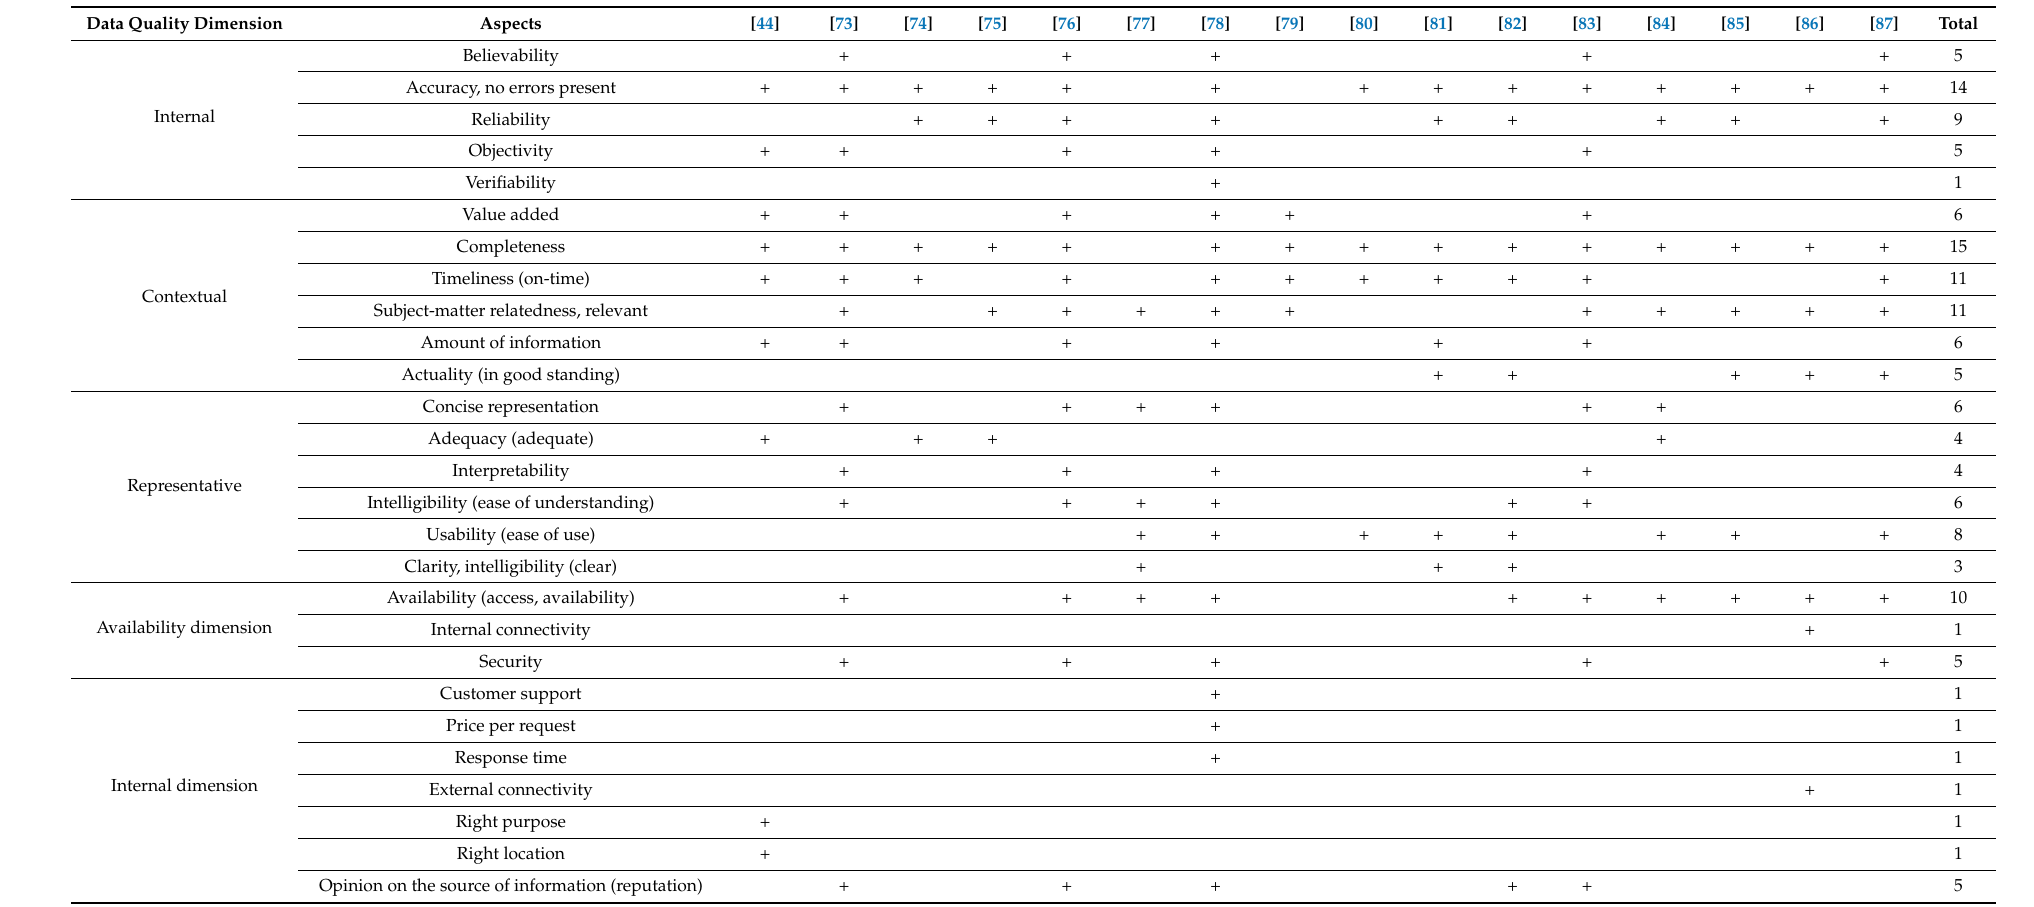
Table A2. Dimensions of data quality assessment available in the